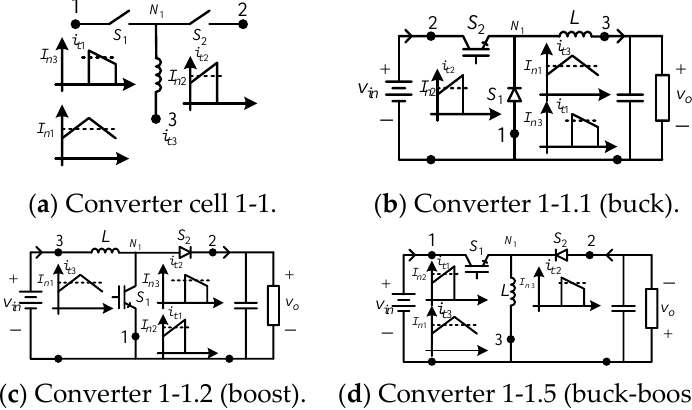
Figure 5. Converter cell 1-1 and three DC – DC converters derived from it .